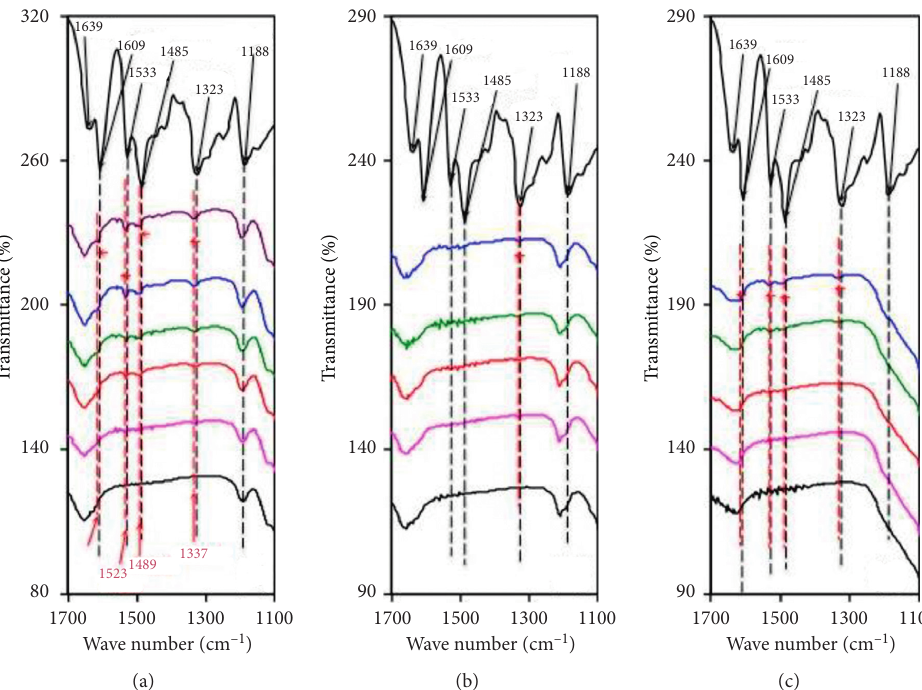
Figure 6: FTIR spectra of PAL (a), SEP (b), and ZEO (c) after SO sorption from different initial concentrations showing the enlargement at the wavenumbers of 1100–1700cm − 1